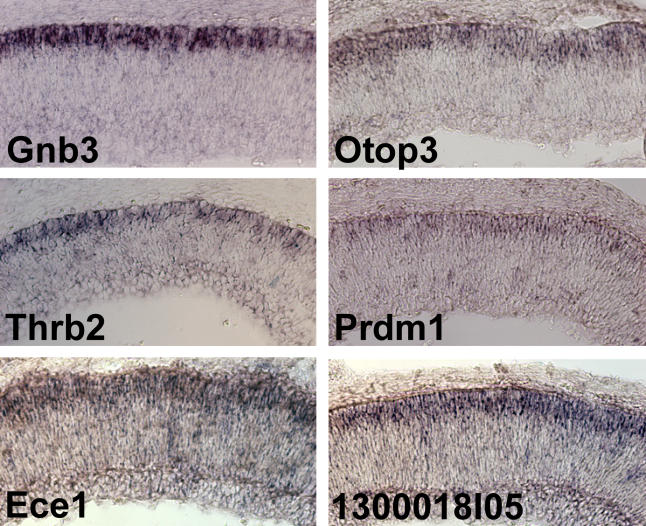
Some of the Genes Up-Regulated in rd7 Show an Early Photoreceptor Pattern of Expression
Gnb3 and Thrb2 are both previously characterized cone genes that show staining at the scleral edge of the embryonic mouse retina in cells that will differentiate into photoreceptors. Ece1 and Otop3 are two novel cone genes identified in this study that were up-regulated in rd7 and also showed an early photoreceptor pattern of expression. Prdm1 and RIKEN cDNA 1300018I05 (Figure 1, genes G48 and G49, respectively) are two other genes that had either undetectable signal (Prdm1) or no apparent change in expression pattern in adult rd7 mutants (RIKEN cDNA 1300018I05), but which also showed staining in the embryonic retina in a presumptive photoreceptor pattern. All images are from E17.5 retina except Gnb3, which was from E16.